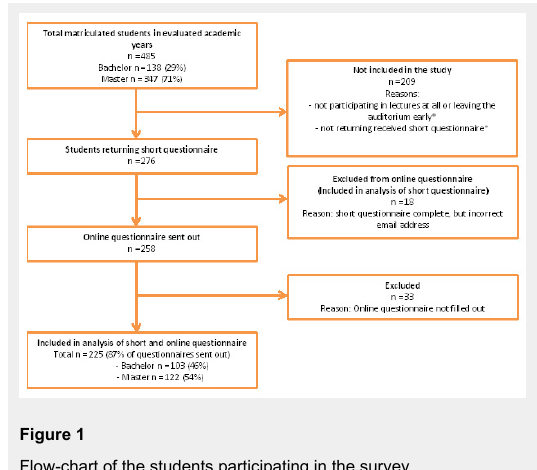
Figure 1 Flow-chart of the students participating in the survey. *Exact number of participating students (i.e., denominator) in lectures